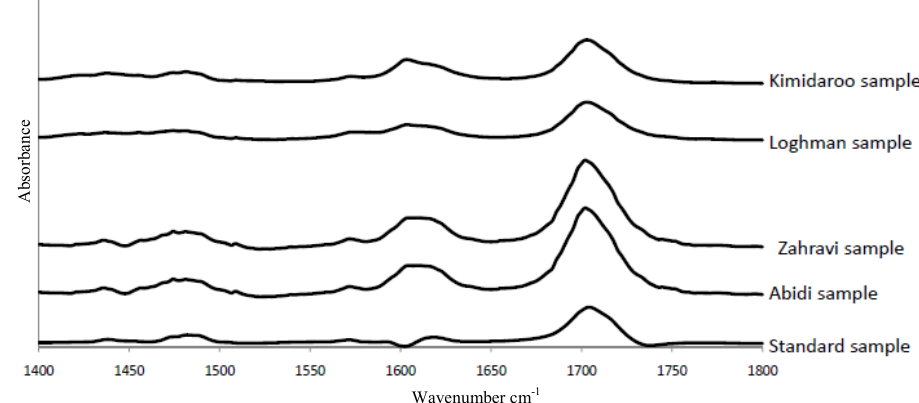
Figure 2. FTIR spectra of lorazepam standard in chloroform at a concentration of 0.16 mgg -1 and extracts of each one of the four pharmaceuticals assayed. Instrumental conditions: 25 scans averaged per spectra, 4 cm -1 nominal using a background of the cell filled with chloroform. Not: spectra were shift on the absorbance axis to clearly show their bands.